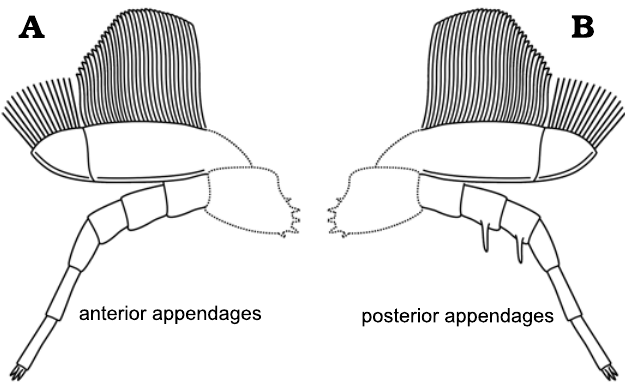
Fig. 9. Biramous appendages reconstruction for the cheirurid trilobite Anacheirurus adserai , showing the anterior ( A ) and the posterior ( B ) mor- phology. Dashed lines indicate inferred proximal parts of the